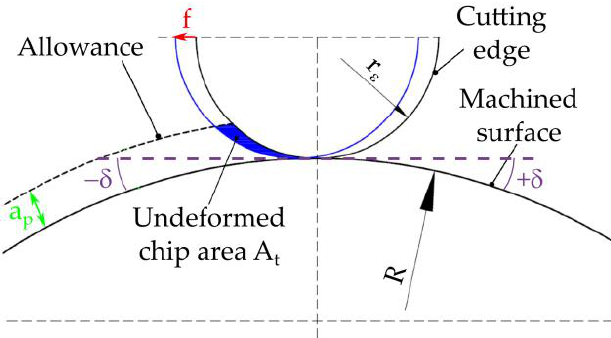
Figure 1. Scheme of forming undeformed chip area A t .